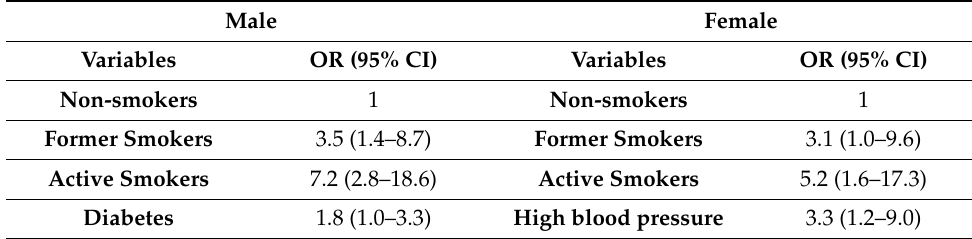
Table 2. Multiple logistic regression analysis of PAD